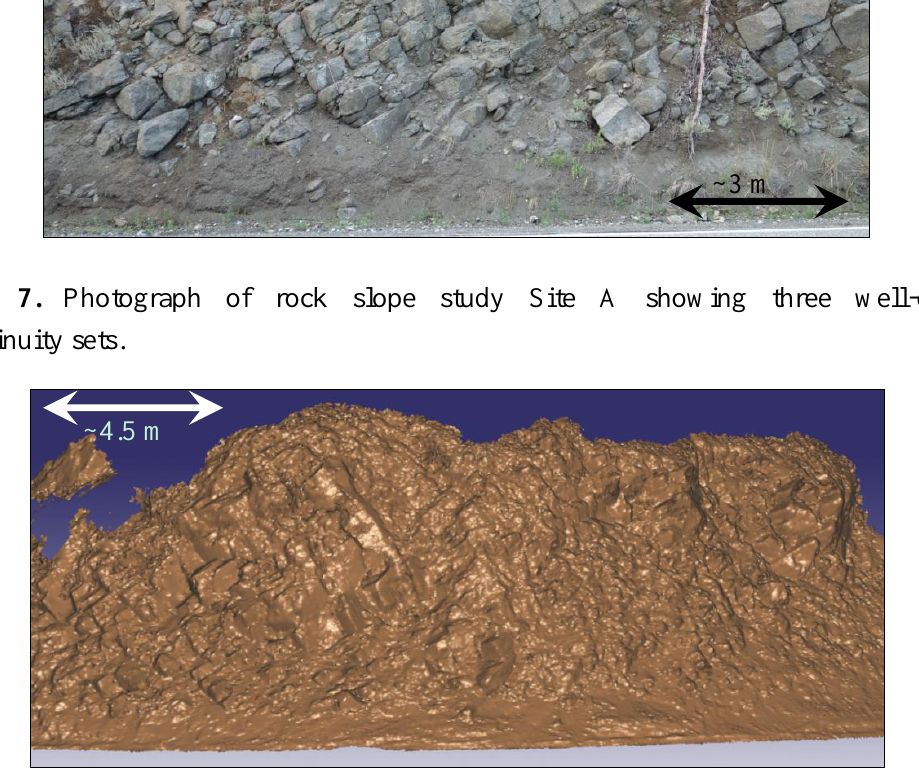
Figure 8. Results from an approximately 35 m section of exposed rock at Site A (0.05 m cell size surface model from